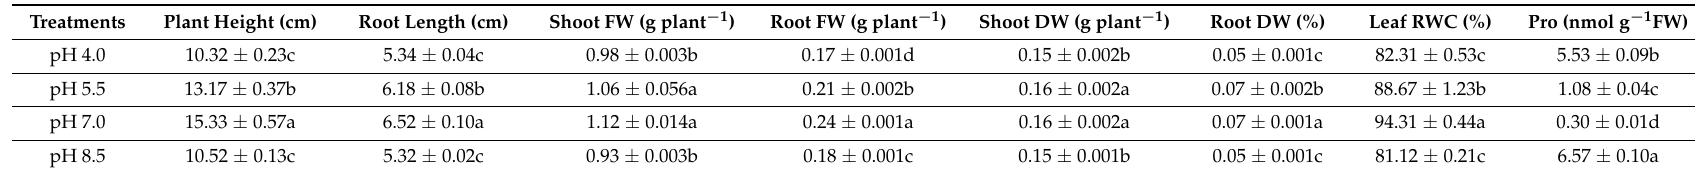
Table 1. Shoot and root fresh weight, shoot and root dry weight, leaf RWC, and Pro content in leaves of wheat ( Triticum aestivum L) seedlings under different levels of pH. Means ( ± SD) were calculated from three replications ( n = 3) for each treatment. Values with different letters are significantly different at p ≤ 0.05 when applying Fisher’s LSD